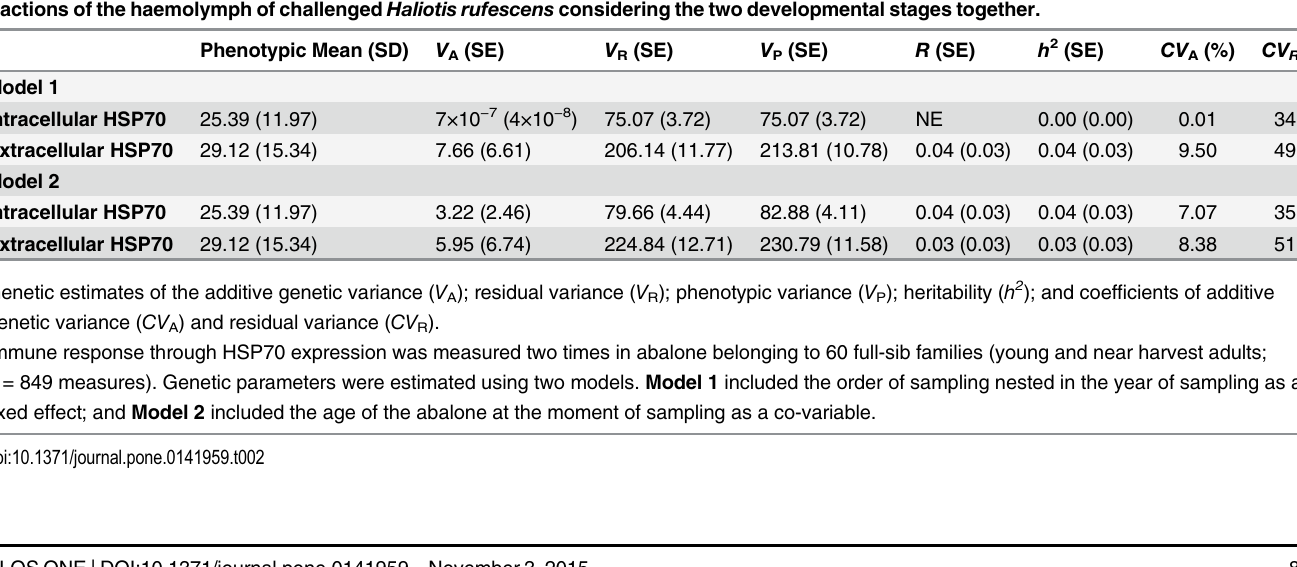
Table 2. Phenotypic means and genetic estimates for HSP70 induced levels, measured in the haemocyte (intracellular) and serum (extracellular) fractions of the haemolymph of challenged Haliotis rufescens considering the two developmental stages together. Phenotypic Mean (SD)